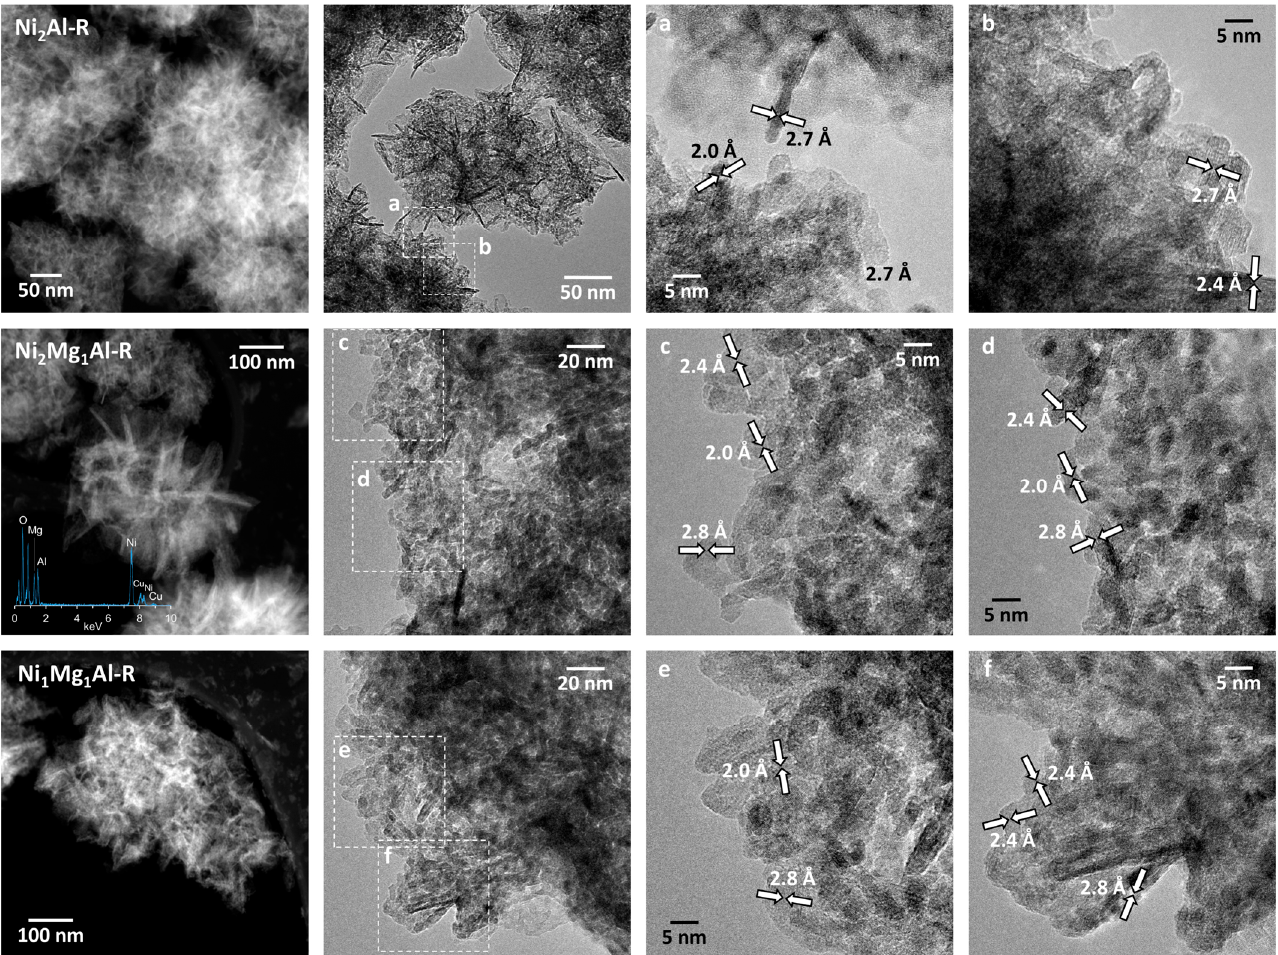
Figure 4. TEM analysis of Ni 2 Al-R ( top row ), Ni 2 Mg 1 Al-R ( center row ), and Ni 1 Mg 1 Al-R ( bottom row ): HAADF-STEM images (1st column), bright-field TEM images (2nd column), and HRTEM images of the selected areas labelled a to f in the bright-field TEM images (3rd and 4th columns). Arrows mark the measured lattice fringes